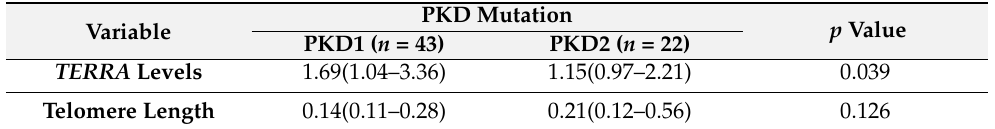
Table 2. Comparison of hybrid TERRA levels and telomere length in patients with different PKD mutations; data were summarized as medians (quartiles